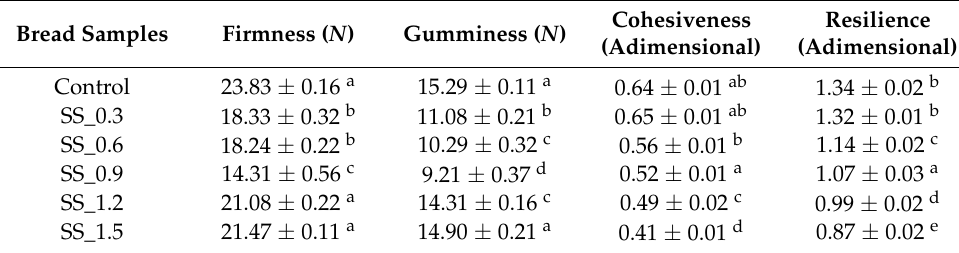
Table 7. Texture parameters of the bread samples with different levels of sea salt with low sodium content (SS) additions.